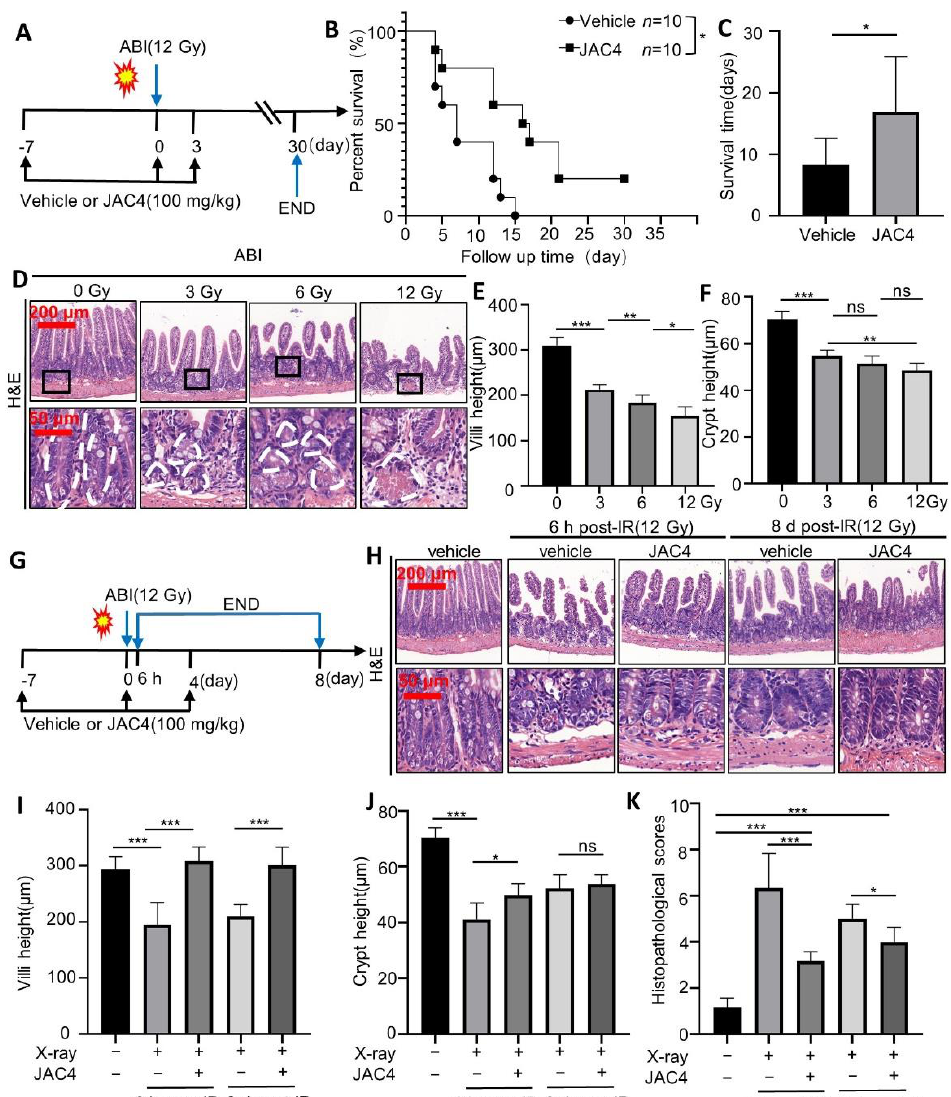
Figure 1. JAC4 improves the survival rate of mice and reduces the damages of intestinal epithelium after ABI. ( A ) C57BL/6 mice (n = 10) were administered JAC4 (100 mg/kg) or vehicle by gavage for 7 days. On the seventh day, mice were exposed to radiation (12 Gy). JAC4 treatment was continued for an additional 3 days and then monitored for 30 days. ( B ) Kaplan–Meier survival analysis of mice exposed to 12 Gy ABI ( p < 0.05, n = 10 per group). ( C ) The average survival time of the two groups of mice ( p < 0.05). ( D – F ) Hematoxylin and eosin (H&E) staining of jejunum and quantification of the villus height and crypt height. Mice (n = 6) were administered JAC4 (100 mg/kg) or vehicle by gavage daily for 7 days prior to 3/6/12 Gy ABI; JAC4 treatment was continued for an additional 4 days. ( G ) Mice (n = 6) were administered JAC4 (100 mg/kg) or vehicle by gavage for 7 days. On the seventh day, mice were exposed to radiation (12 Gy). JAC4 treatment was continued for four days. Then, serum and small intestine tissues were collected at 6 h and 8 d, respectively. ( H ) H&E staining in the jejunum. ( I ) Villus height, ( J ) crypt height, and ( K ) histopathological scores. The results are presented as mean ± SD (n = 6) (* p < 0.05; ** p < 0.01; *** p < 0.001; ns: p > 0.05).